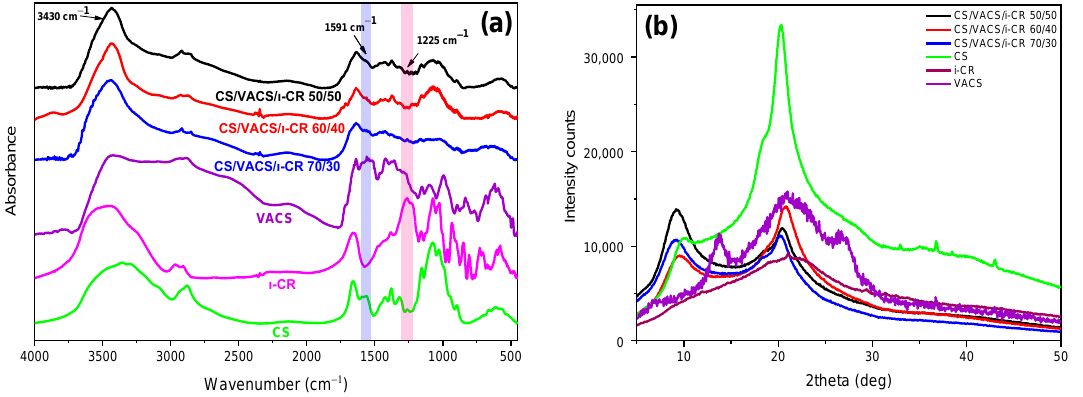
Figure 5. ( a ) FTIR spectra and ( b ) X-ray spectra of the samples CS, VACS, iCR, and CS/VACS/iCR with 50/50, 60/40, and 70/30 ratios.